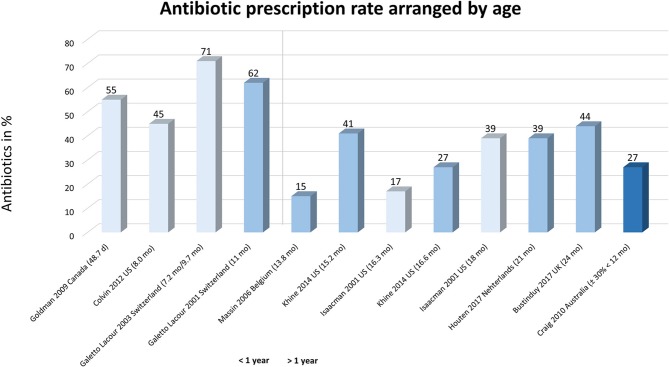
Antibiotic prescriptions arranged on age in children with fever. Studies are arranged by age, i.e., left represents younger children to right (older ages). Light bars represent studies with a low quality.